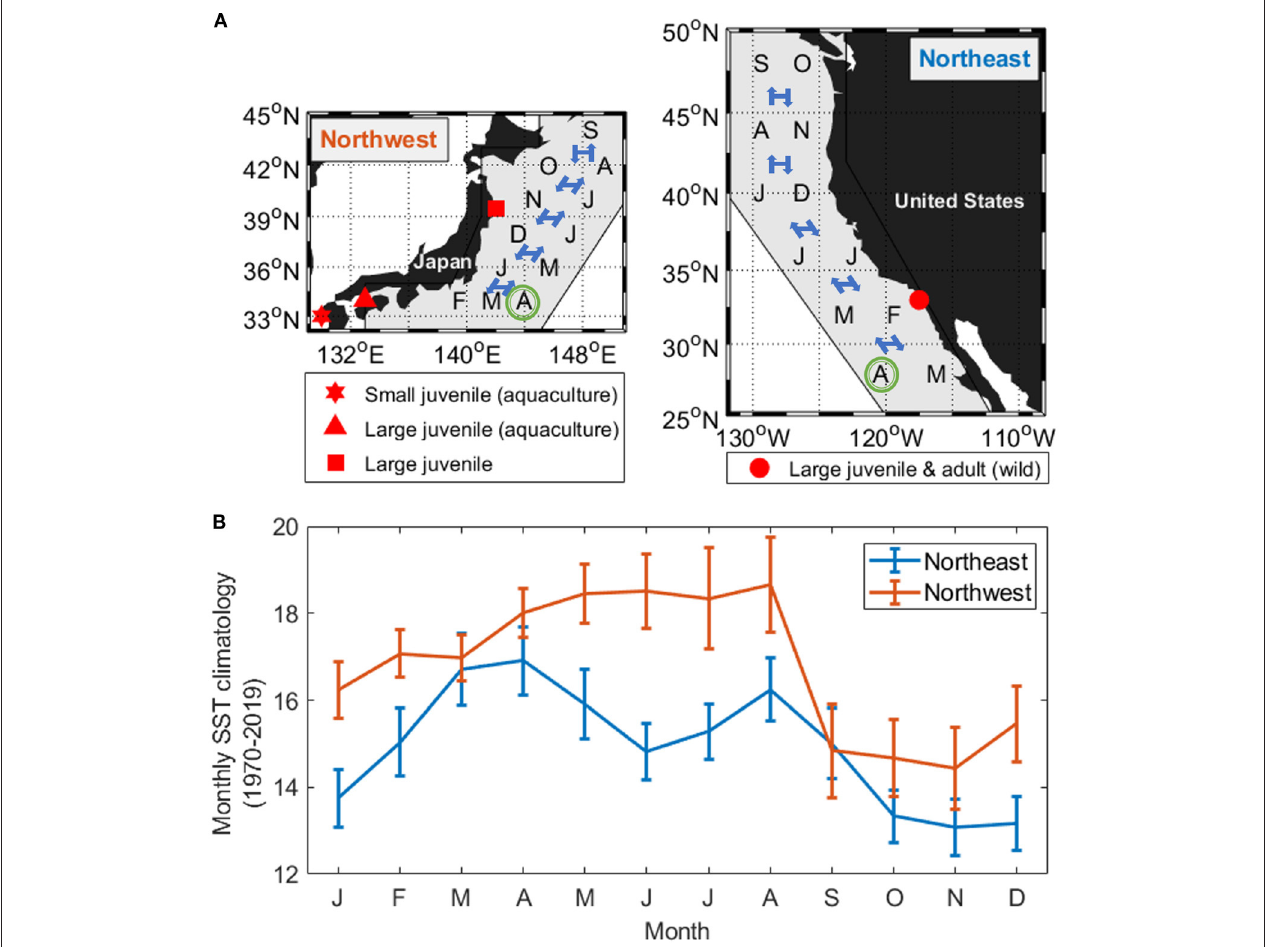
FIGURE 1 | (A) Pacific chub mackerel collection sites (red markers) in relation to the species distribution area (gray polygon), assumed hatch month (April, green circle), and the mean monthly latitude position shift of the Northwest stock (left) and Northeast stock (right). (B) Mean monthly sea surface temperature (SST climatology averaged from 1970 to 2019 ± standard deviation) experienced by the mean latitudinal position of the two stocks.